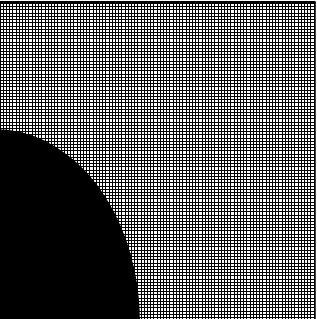
Figure 3. Mesh plotted on analyzed geometry.